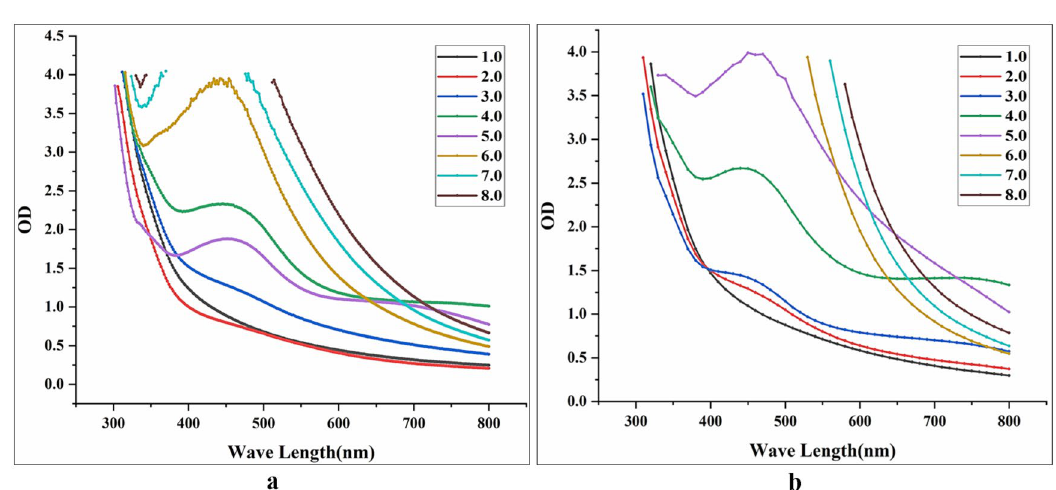
Figure 6. Optimal time for AgNPs synthesis: AgNPs solutions were synthesized under the optimal conditions at 28 °C in the dark, Ag + concentration is 10 mM, and adjust the pH of HX-YS treated AgNPs solutions to 6.0, LPP-12Y is 5.0; OD value was determined everyday at the maximum absorption wavelength of AgNPs: the maximum absorption wavelength of AgNPs solutions treated with HX-YS fermentation broth is 450 nm, while LPP-12Y is 430 nm [( a ) solutions are treated with HX-YS; ( b ) solutions are treated with